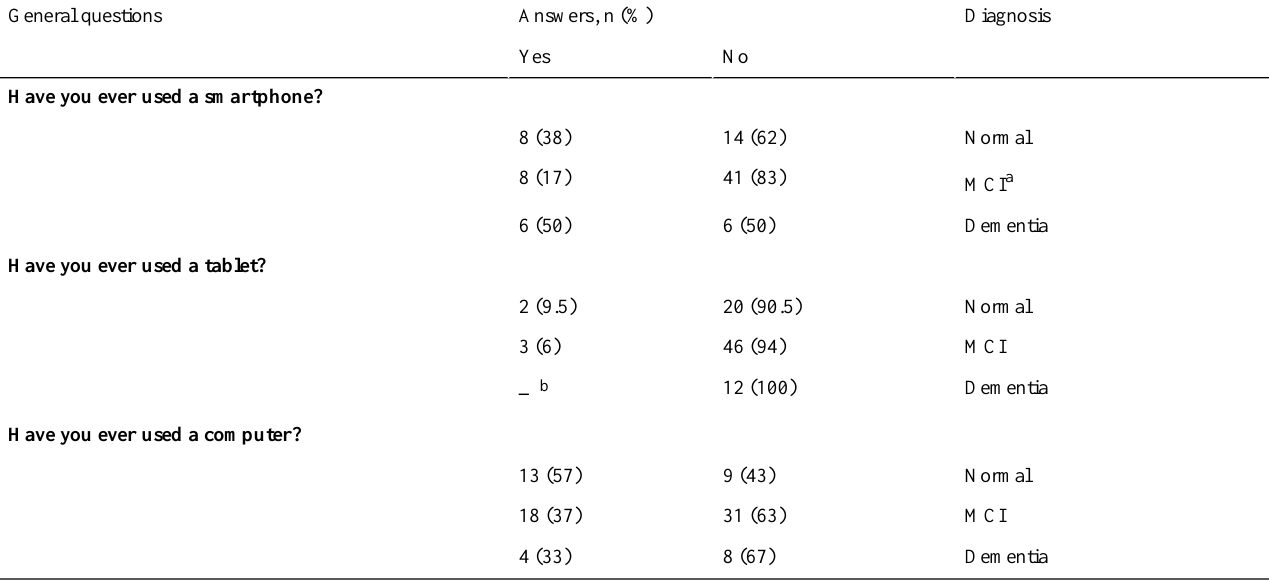
Table 3. System acceptance results from yes or no questions.